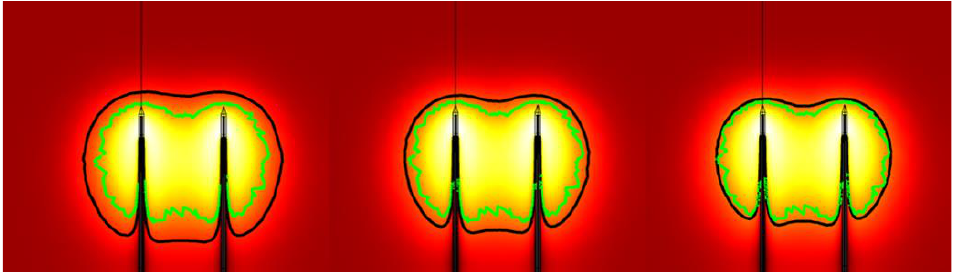
Figure 5. The results of the 54 °C, 60 °C, and 65 °C isothermal surface and Arrhenius model after 8 min of treatment time.